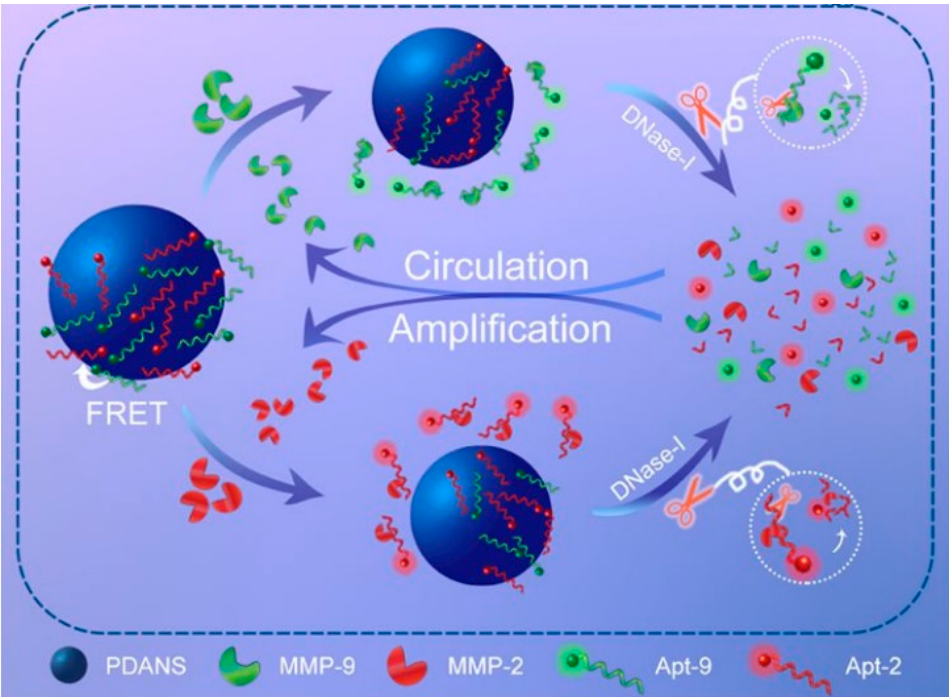
Figure 11. Optical aptasensors for matrix metalloproteinase-9 and -2 in urine and tissue homoge- nate. Colloidal polydopamine NSs coated with fluorescent aptamers are reacted with the metallo- proteinases whose fluorescence is quenched. Following the binding with the targets, the aptamers detach and recover the fluorescence; in these conditions, DNase-I cuts the detached aptamers and leads to fluorescent amplification. Image adapted from [89] with permission of American Chemical Society,